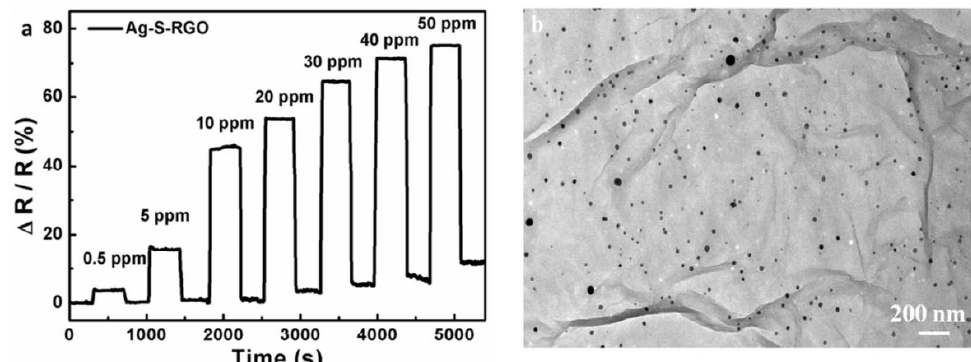
Figure 13. ( a ) Response of the Ag-S-RGO sensor as function of time (s) in various concentrations of NO 2 gas and ( b ) TEM image of Ag nanoparticles on S-RGO sheets, “Reprinted/adapted with permission from Ref. [119]. 2014, Huang, L. et al.”.